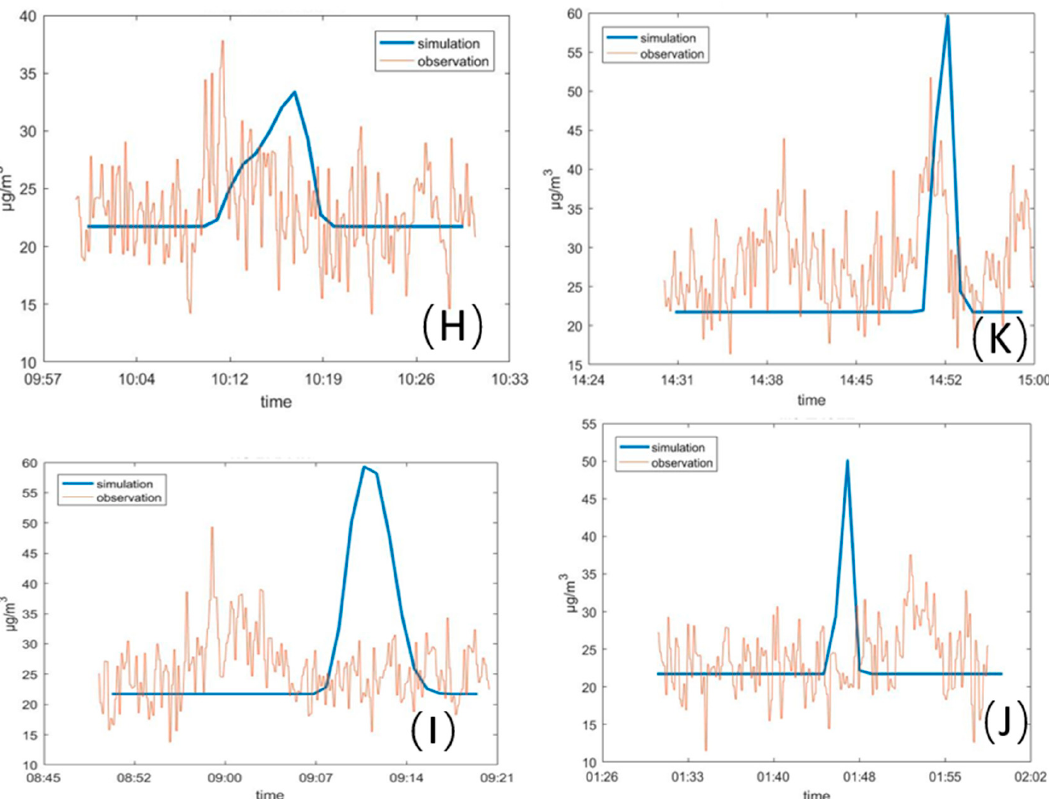
Figure A1. Time-series comparison of simulations and observations of typical vessels. ( A ) vessels A, ( C ) vessels C, ( D ) vesselsD, ( E ) vessels E. ( F ) vessels F, ( G ) vessels G, ( H ) vessels H, ( K ) vessels K, ( I ) vessels I, ( J ) vessels J.